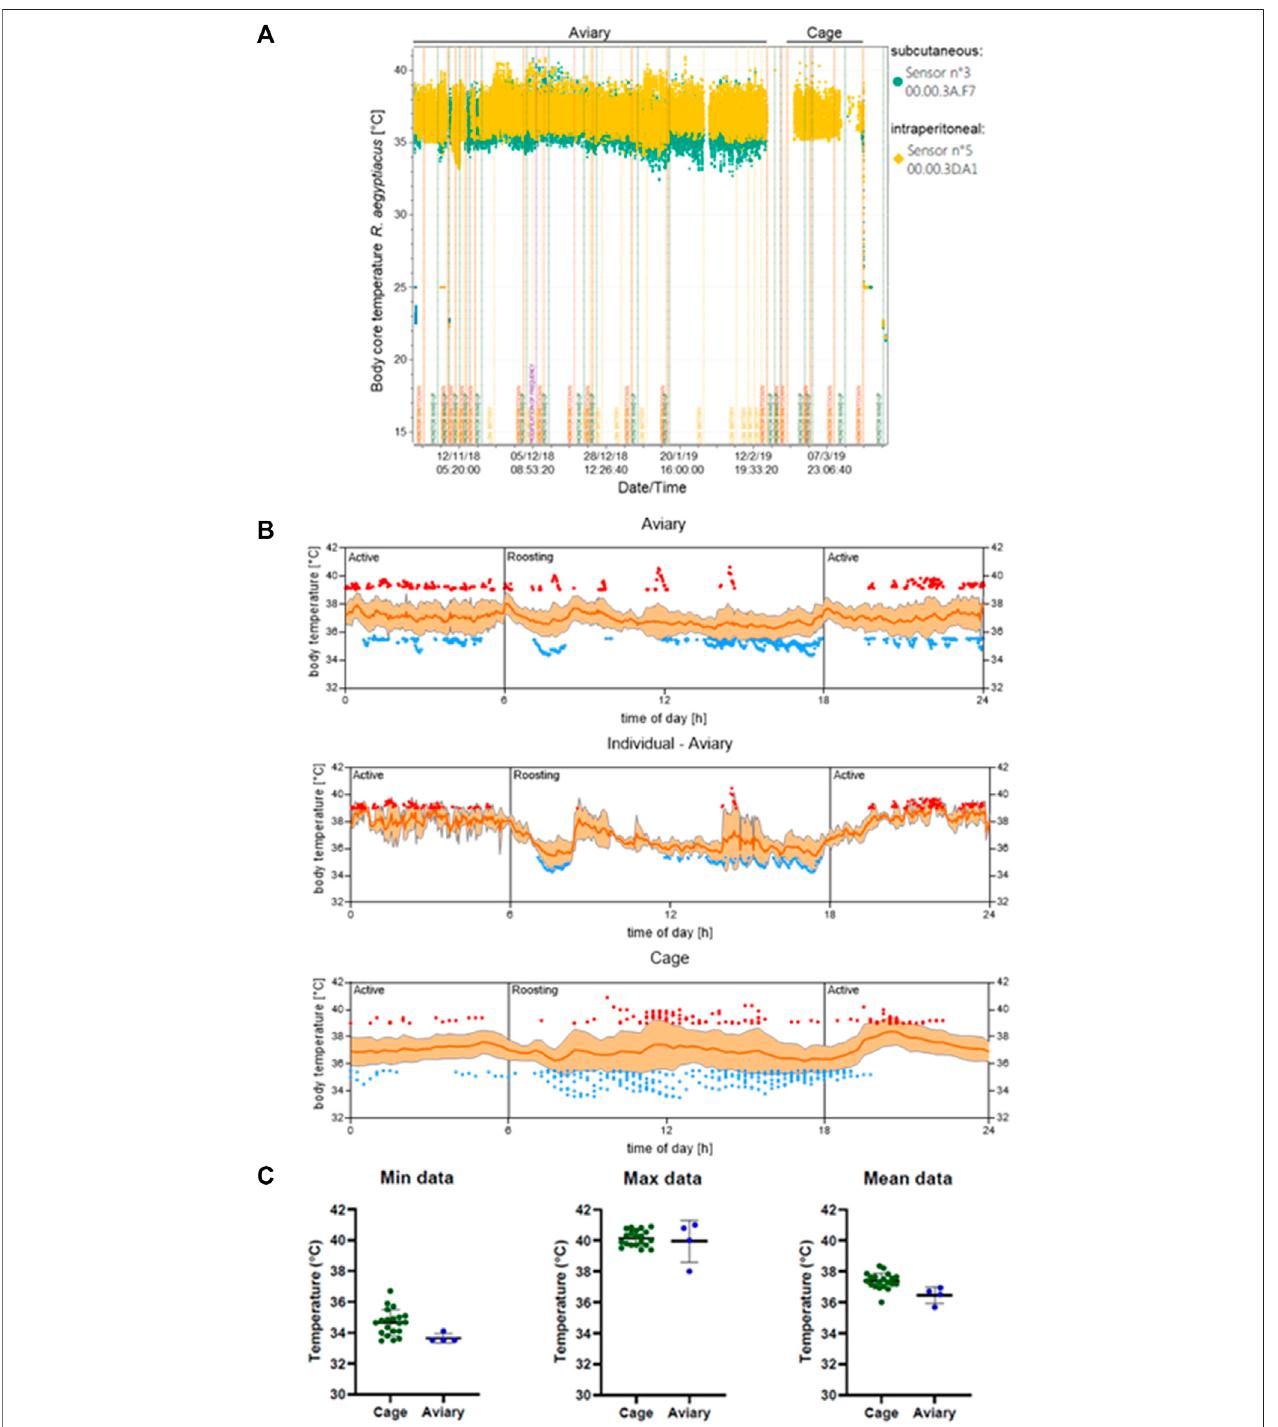
FIGURE 2 | Body core temperature of R. aegyptiacus bats is dependent on the transmitter location. (A) The difference in determined body temperature of R. aegyptiacus bats is exemplarily shown for one bat with a subcutaneously implanted transponder (sensor n ° 3), and one bat with an intraperitoneally implanted transponder(sensorn ° 5,yellow). (B) Thebodytemperatureofindividualsintheaviary( n =4,atotalof17individualmeasuringdayswith11,495valuesaredepicted)adin acage( n =6,atotalof29individualmeasuringdayswith2,735valuesaredepicted)wasdetermined.Low( ≤ 35.5 ° C)andhightemperatures( ≥ 39 ° C)ofallindividuals areindicatedinblue andred,respectively.Oneindividualcarryinganintraperitonealtransmitterisdisplayed separatelyforclaritypurposes.Datarepresentsseveraldays ofmeasurement ofallindividualscarryingatransmitter.Orangelinerepresents themean,±SDdisplayed asshading. (C) Meanaswellasmaximumand minimumvalues ofanimalscarryingaintraperitonealtransmitteraredisplayed.ThetemperaturewasassessedfromOctober-February(aviary) andFebruary-March(cage)andvaluesare depicted from 12:00 to 24:00.